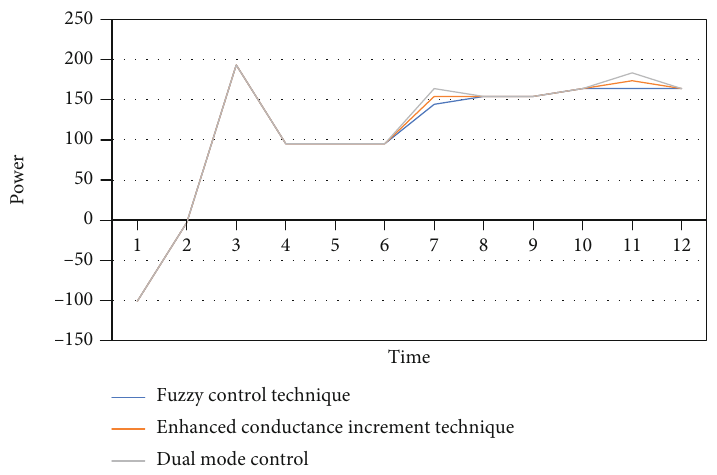
Figure 5: When the environment changes, the balance of power fl uctuates.